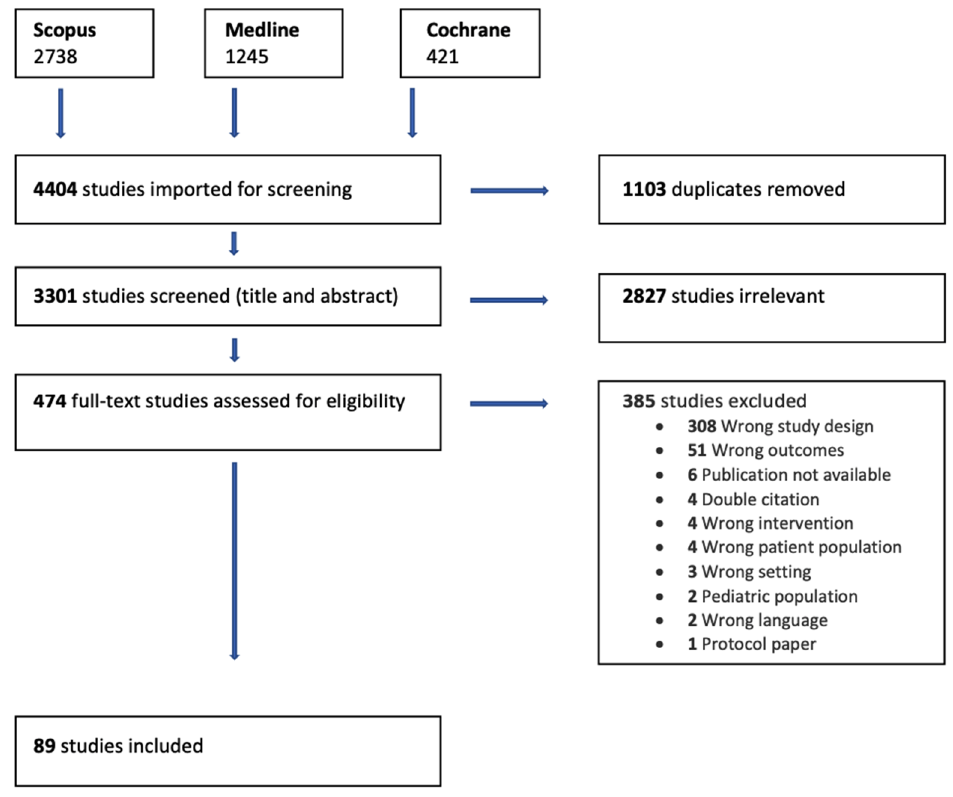
Figure 1. PRISMA flow diagram of the study selection process.